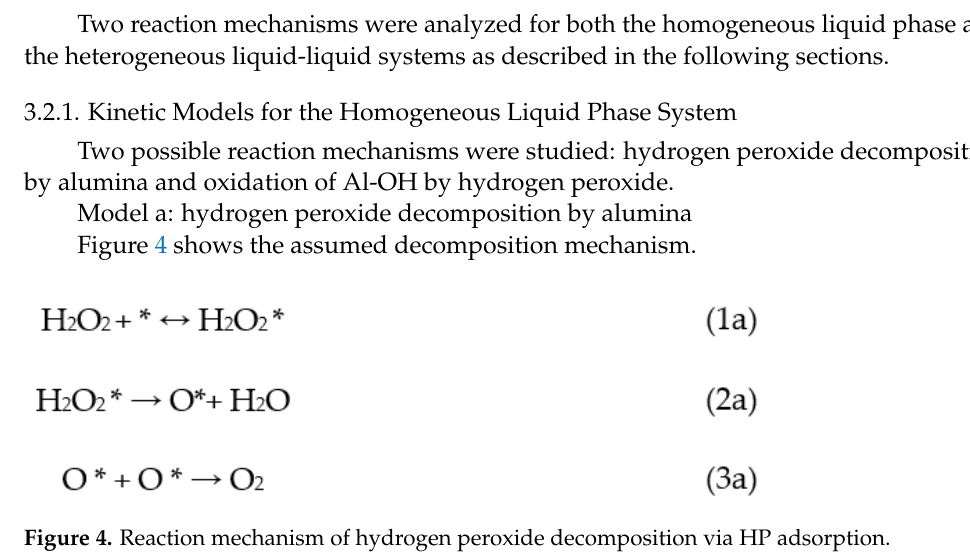
Figure 4. Reaction mechanism of hydrogen peroxide decomposition via HP adsorption.